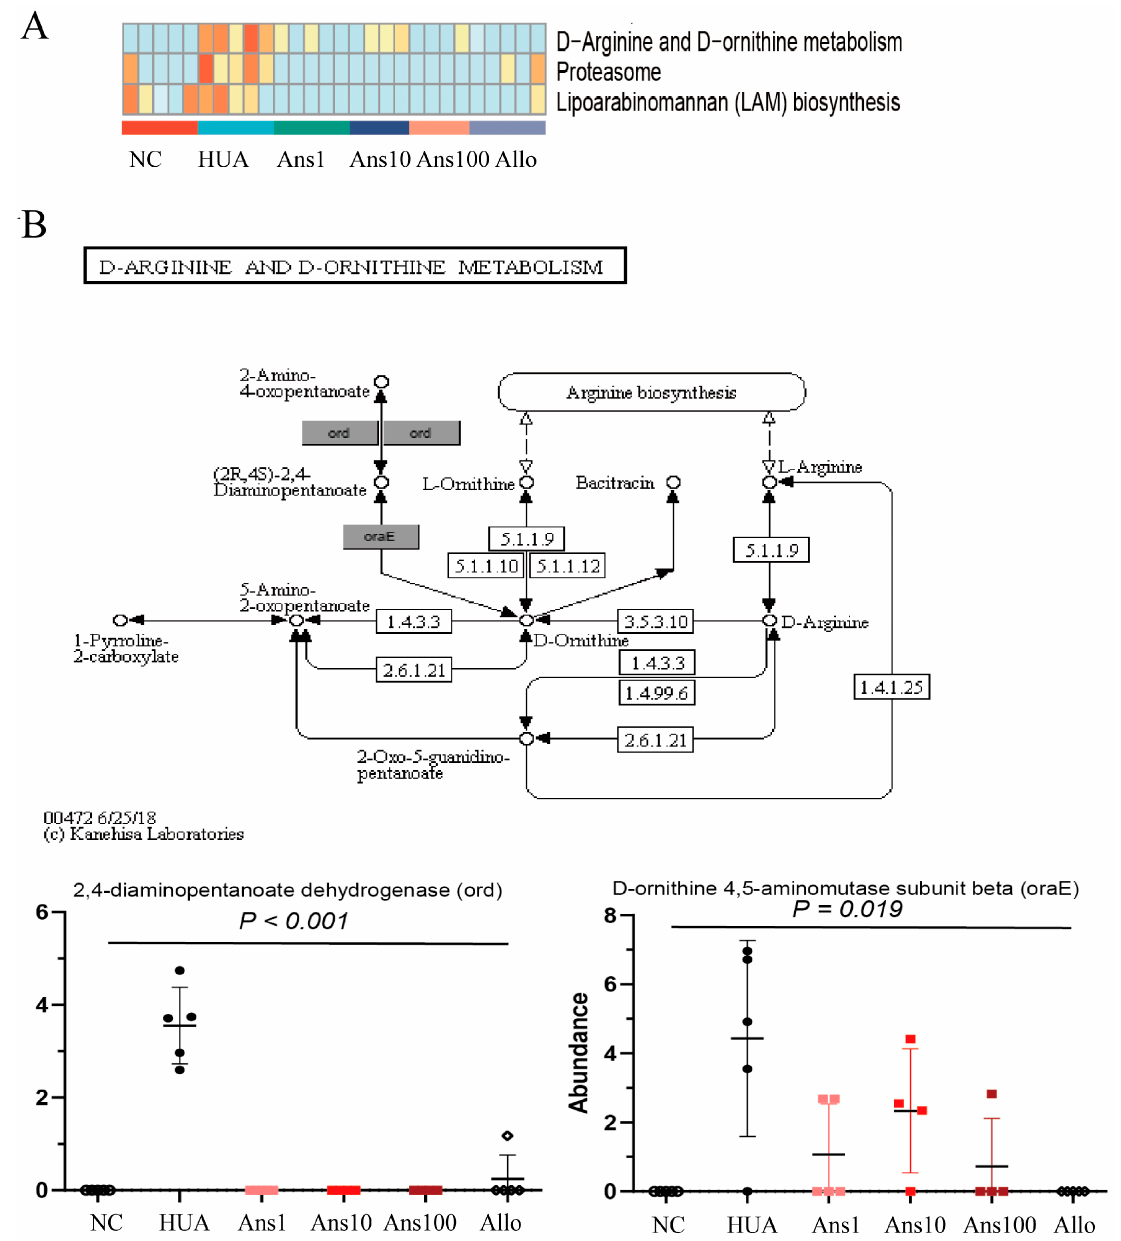
Figure 7. Changes in the metabolic function of gut microbiota: ( A ) three metabolic pathways in the HUA group are richer than other groups, including D-Arginine and D-ornithine metabolism, proteasome and Lipoarabinomannan (LAM) biosynthesis pathways; ( B ) altered genes in the D- arginine and D-ornithine metabolism pathways ( p <